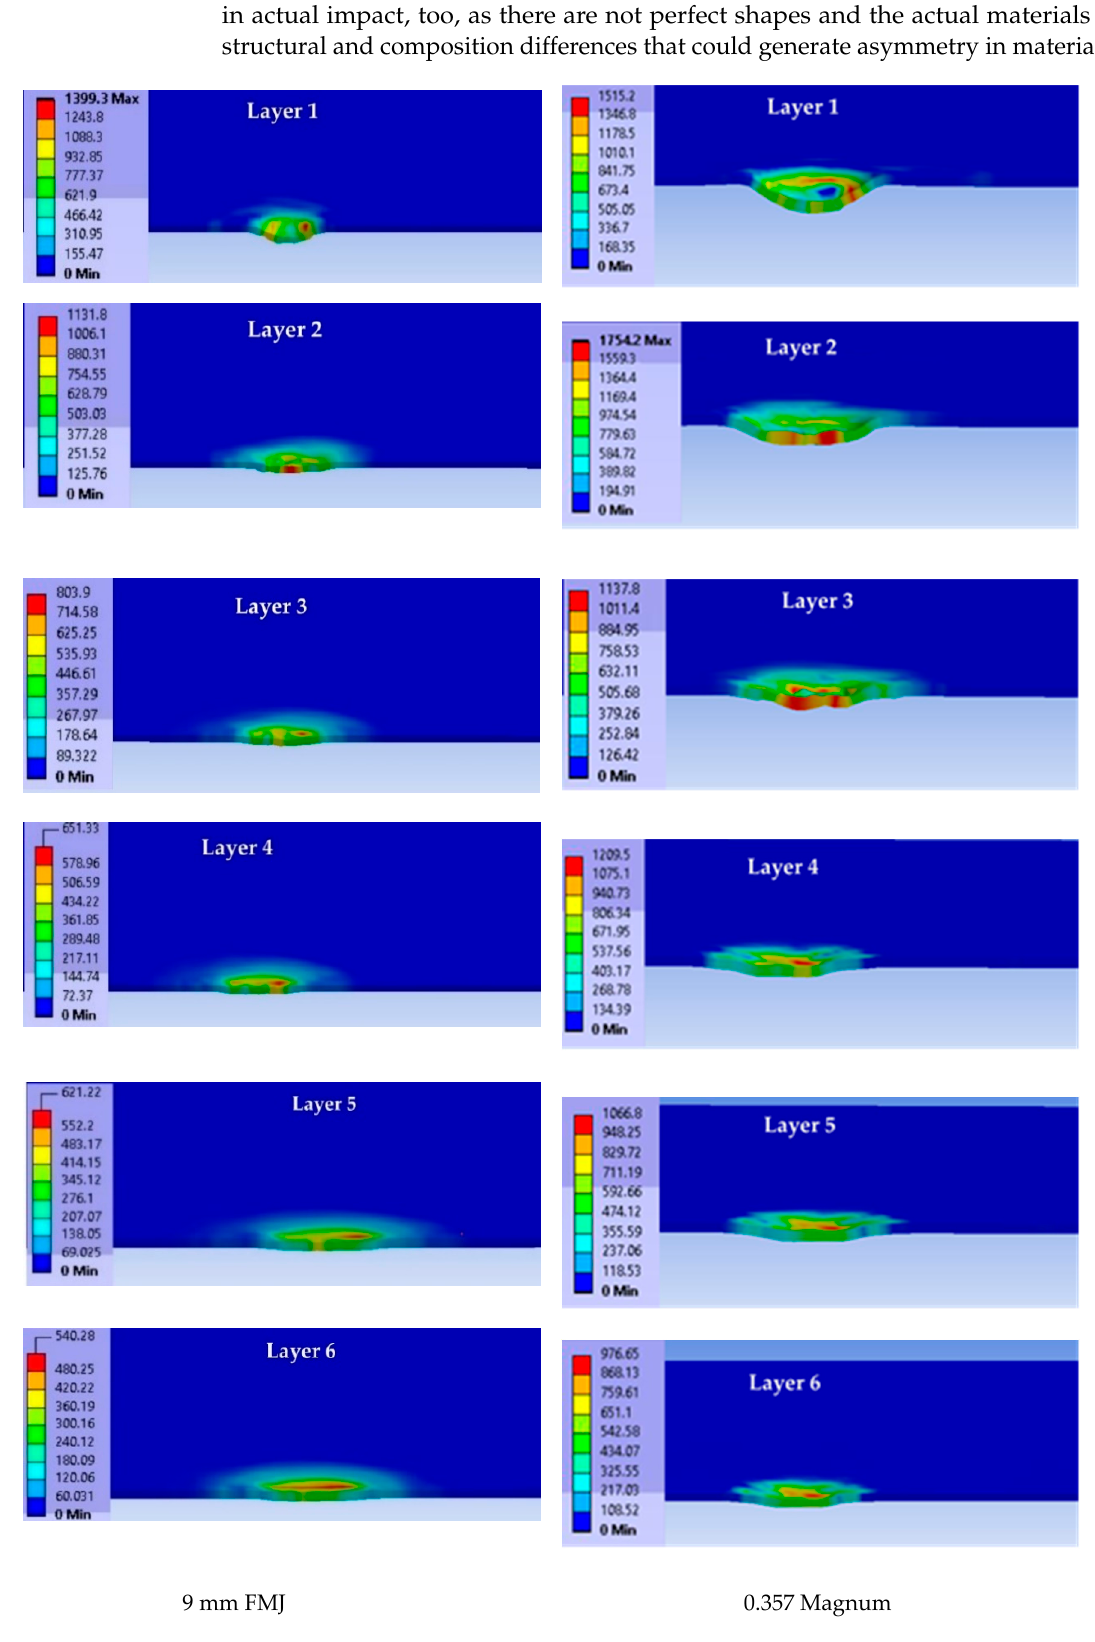
Figure 6. Images of each layer (layer 1 to layer 6) with von Mises stress distributions at moment t = 7.5 × 10 − 6 s (each image has its own color scale for stress values).